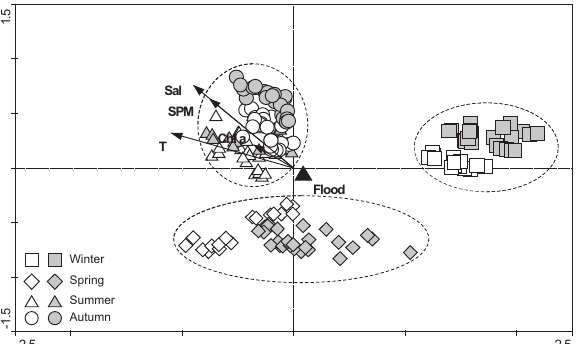
Fig. 5 . – Biplot ordination diagram of the larval fish assemblages in Mondego estuary using the first two canonical correspondence axes. Samples were classified according to season (winter, spring, sum- mer and autumn) and lunar-tide cycle (neap and spring). Significant environmental variables are plotted as arrows (T, temperature; Sal, salinity; SPM, suspended particle matter; Chl a , chlorophyll a ). Tide cycle was also included as a nominal variable “Flood”. White, neap tide; grey, spring tide.